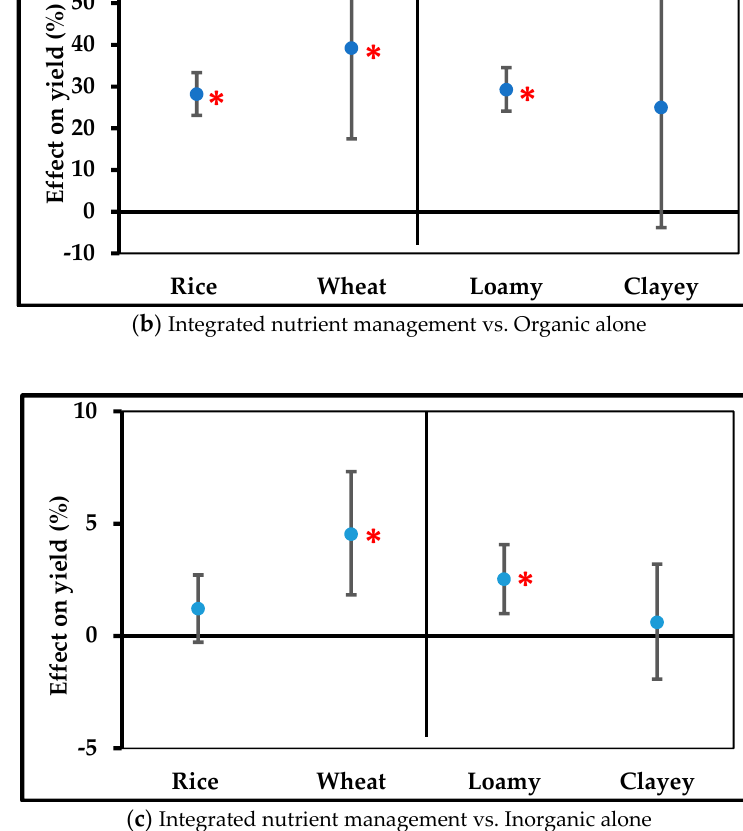
Figure 4. Effect of integrated nutrient management on grain yield vis-a vis control ( a ), organic alone ( b ), and inorganic alone ( c ), separated for rice and wheat crops and for soil texture (loamy and clayey). (Note: Error bars in meta-analysis indicate 95% confidence intervals (CI), where effect of yield was considered significant if 95% CI does not cover zero. * Indicates significant percent yield at p < 0.05).